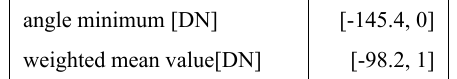
Table 3. Ranges of differences between scan angle dependent methods and maximum